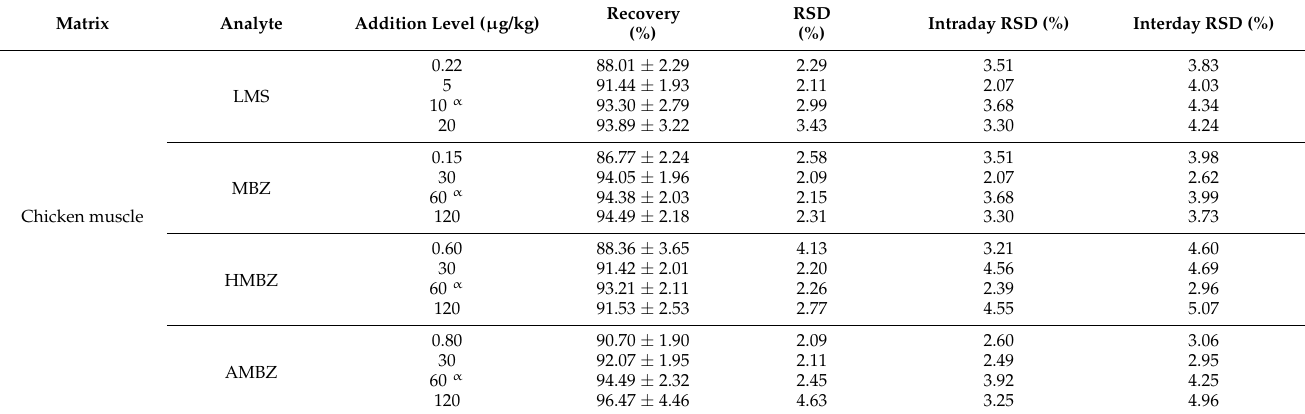
Table 6. Recovery and precision of LMS, MBZ, HMBZ and AMBZ added to blank poultry muscle ( n = 6). Matrix Analyte